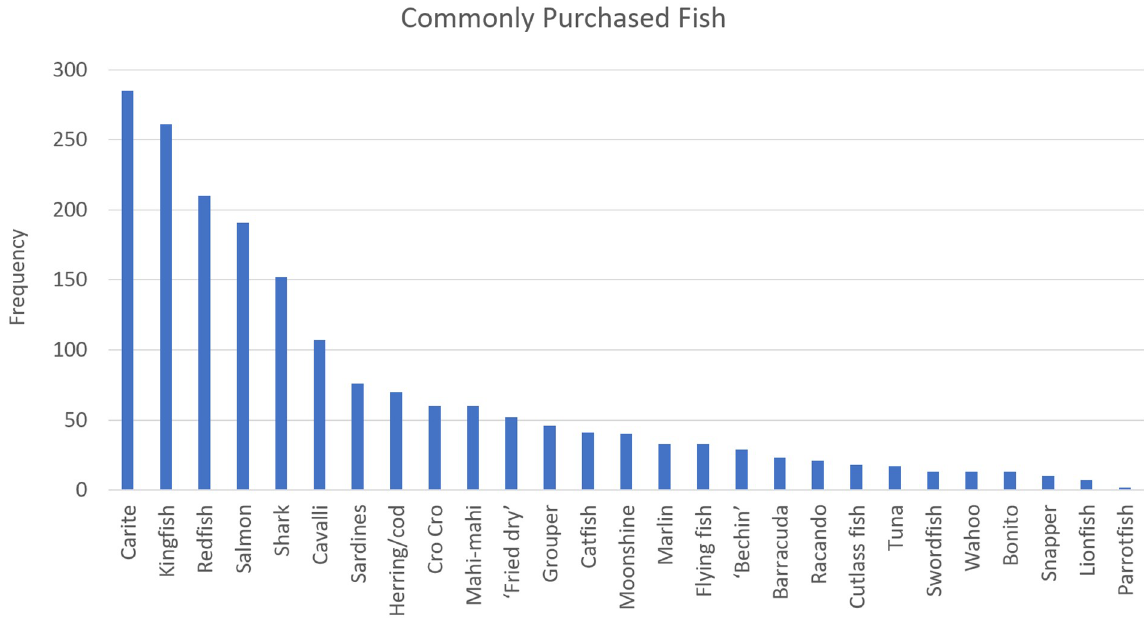
Fig 7. Popularity of different fish among consumers. (See S3 Appendix for Table).